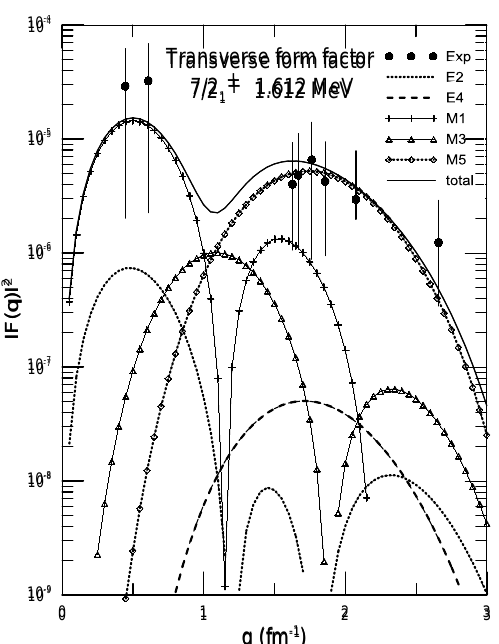
Fig. 3: Theoretical longitudinal and transverse form factors for 7/2 1+ , 1.612 MeV using SkXcsb parameterization compared with experimental data